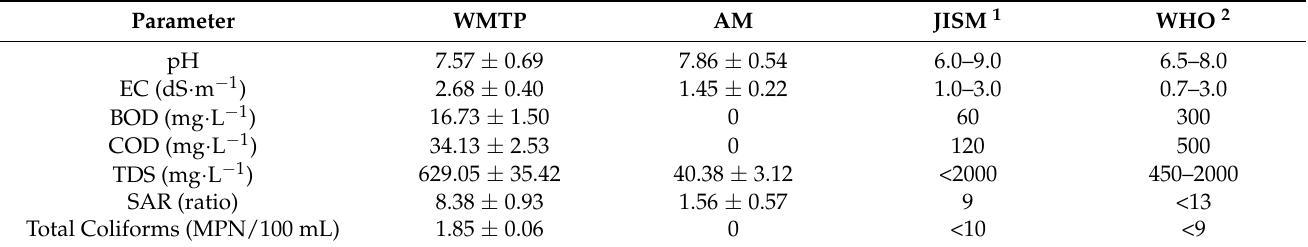
Table 2. Chemical and biological properties of irrigation water from Wadi-Musa Wastewater Treatment Plant (WMTP) and Ain Mousa (AM) sites during 2021. The data are averages ± SD ( n =